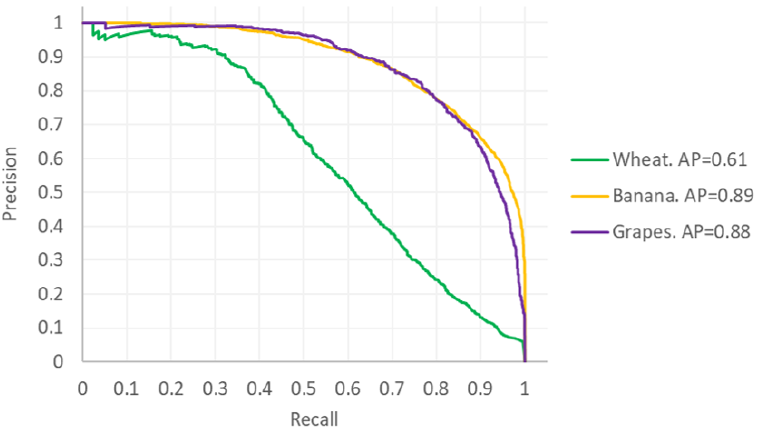
Figure 3. Precision—Recall curves for parts detection, obtained by the D+R method. Unlike the direct regression, this method provides explicit localization of the detected parts, evaluated in these curves. In order to determine if a part detection is a hit or a miss we use the Percentage of Correct Keypoints (PCK) criterion, introduced in [60] and applied as in [8].